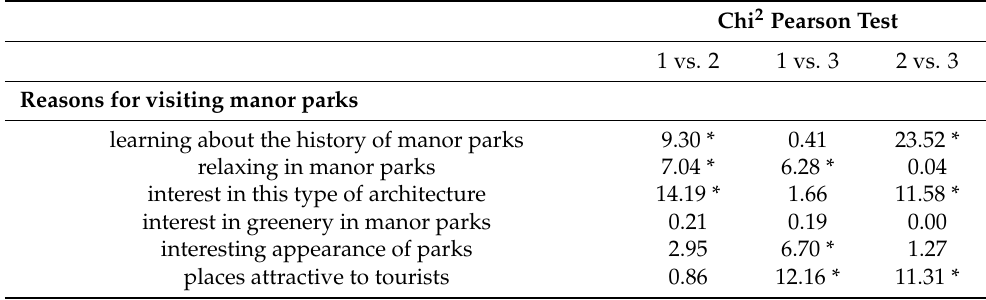
Table 5. Correlation between reasons for visiting manor parks by visitor income (Chi 2 Pearson test for pairs of income